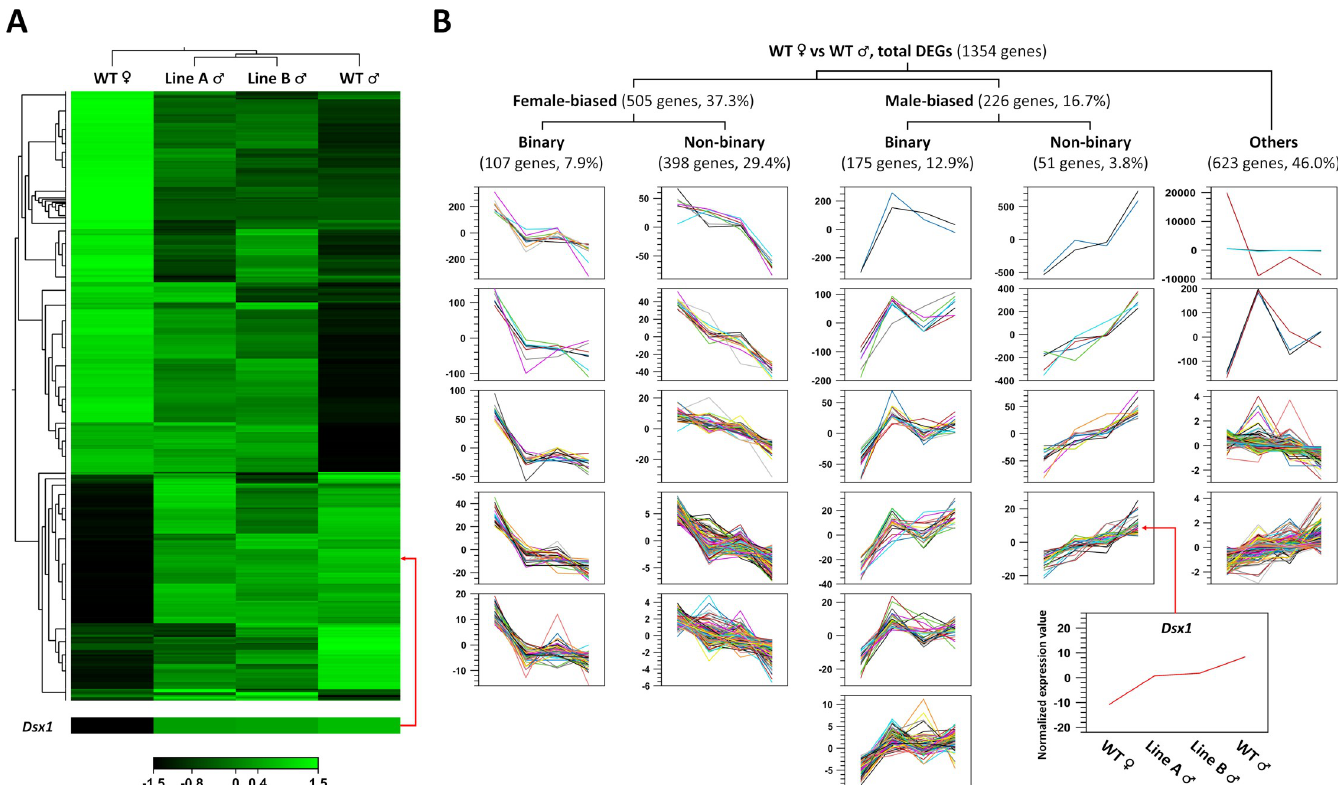
Fig 4. A) Heat map of 1354 differentially expressed genes detected in the wild type female vs. wild type male comparison (EDGE-test). Each row represents one gene. In addition to wild type female and wild type male gene expression (left-most and right-most column), intersex gene expression is also shown (two columns in the middle). A close-in for Dsx1 together with an arrow leading back to its original position is provided at the bottom of the heat map. Color scale indicates normalized logCPM values in which brighter green means stronger expression. B) K-medoids clustering of 1354 genes showed in A) panel. In contrast to the log-transformed expression value used in the heat map, normalized read count values were used in this k-medoids clustering to allow visualization in better resolution. All genes were split into 24 clusters based on their trend of expression (which was already mean-centered) across the 4 positions of sex spectrum (WT female, Line A male, Line B male, WT male). These clusters were subsequently grouped into 5 categories based on their dimorphic properties (see main text for details). Dsx1 was identified as a non-binary male- biased gene in this analysis (bottom right